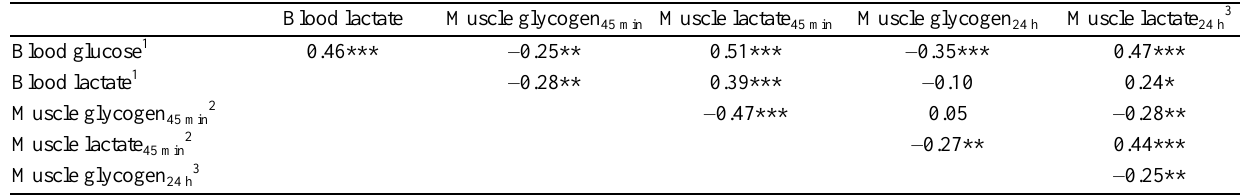
Table 1. Correlation coefficients between blood glucose and lactate levels and muscle glycogen and lactate contents